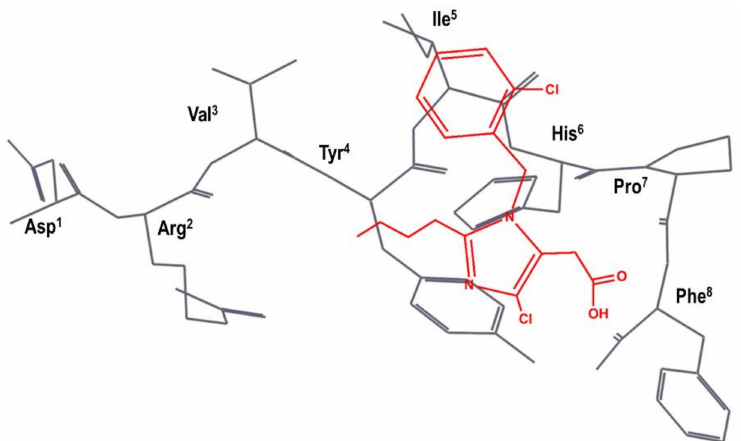
Figure 3. DuPont hypothesis of the superimposition of S-8307 (in red) to the AII bioactive confor- mation (in black), as described in reference [49]. The Figure was re-constructed using the bioactive conformation of AII taken from pdb id: